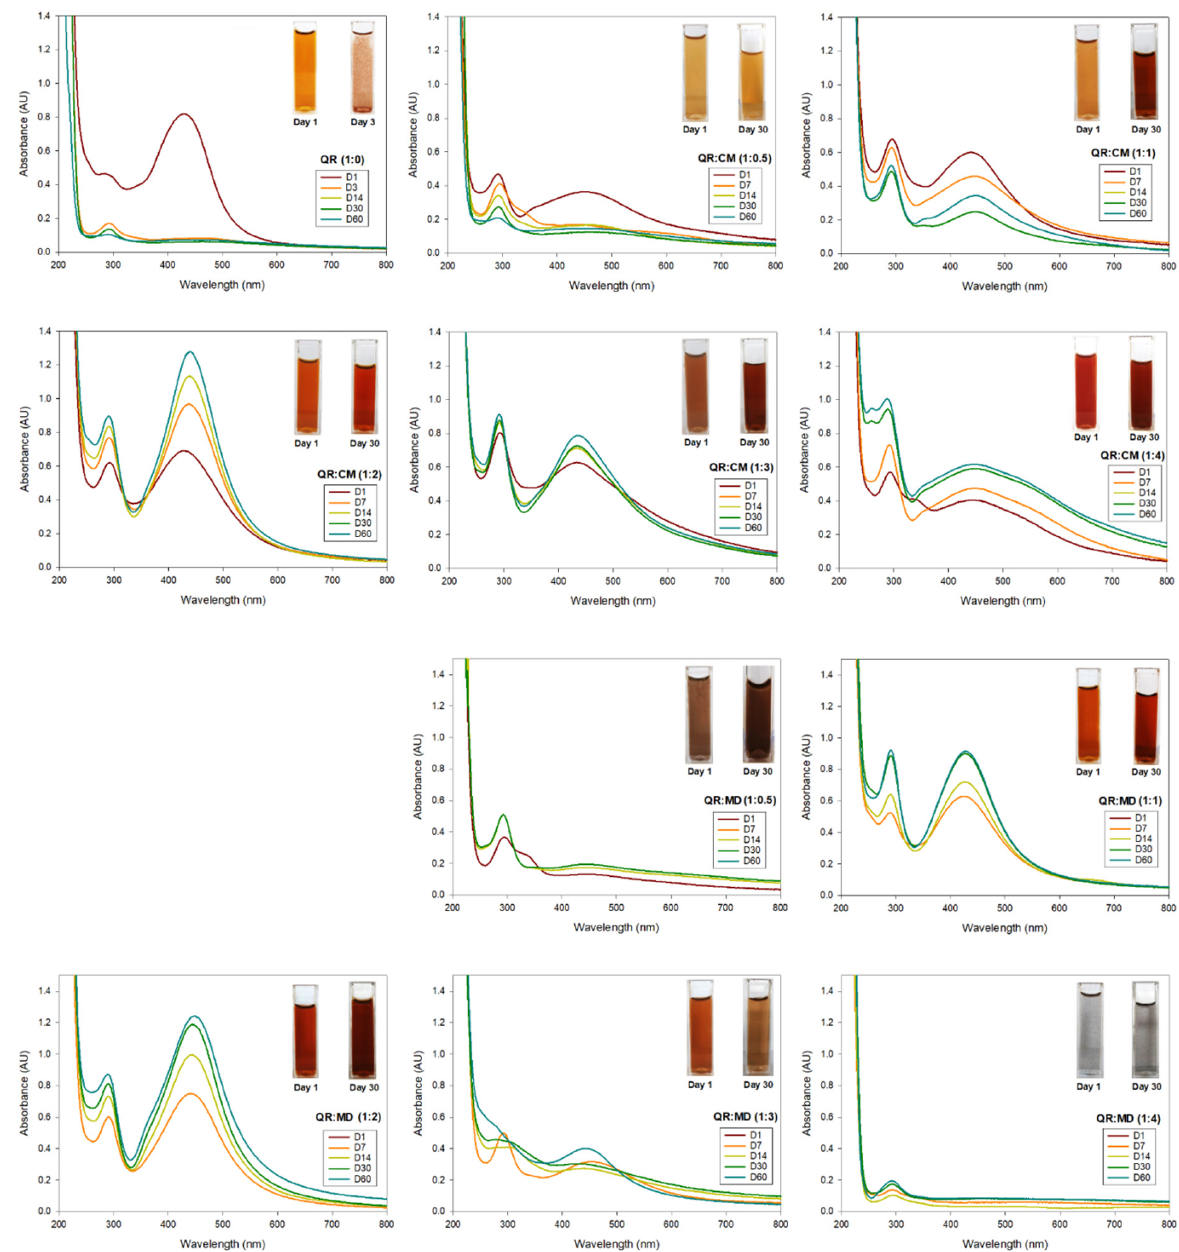
Figure 1. UV-VIS absorption spectra and color change for each AgNPs system at different ratios of quercetin and stabilizing agent: microcrystalline cellulose and maltodextrin for different times.